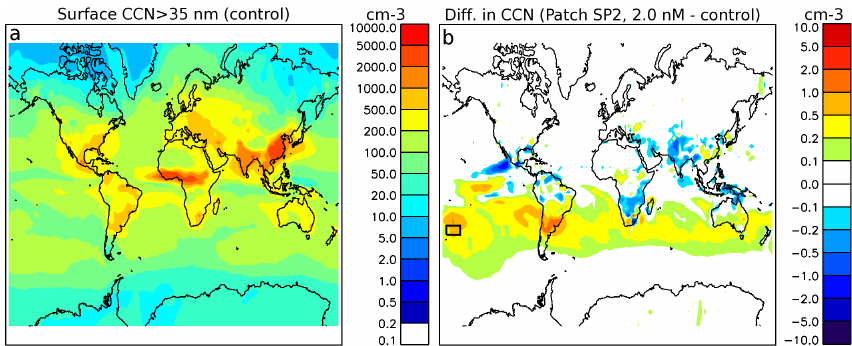
Fig. 3. (a) December mean surface CCN > 35nm concentration for the control simulation and (b) difference in surface CCN > 35nm concentration resulting from the SP2 patch (location indicated by black box) with +2.0nM DMS perturbation.